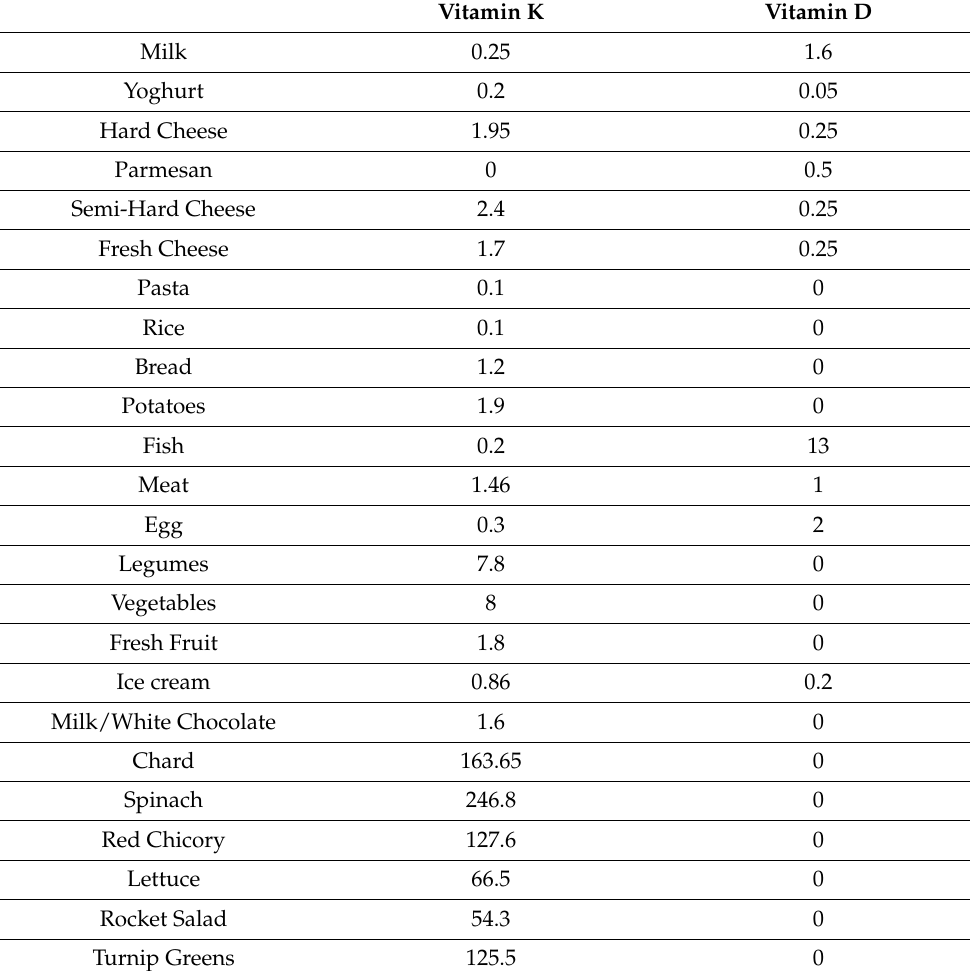
Table A1. Vitamin K and Vitamin D food composition values, data expressed in µ g/100